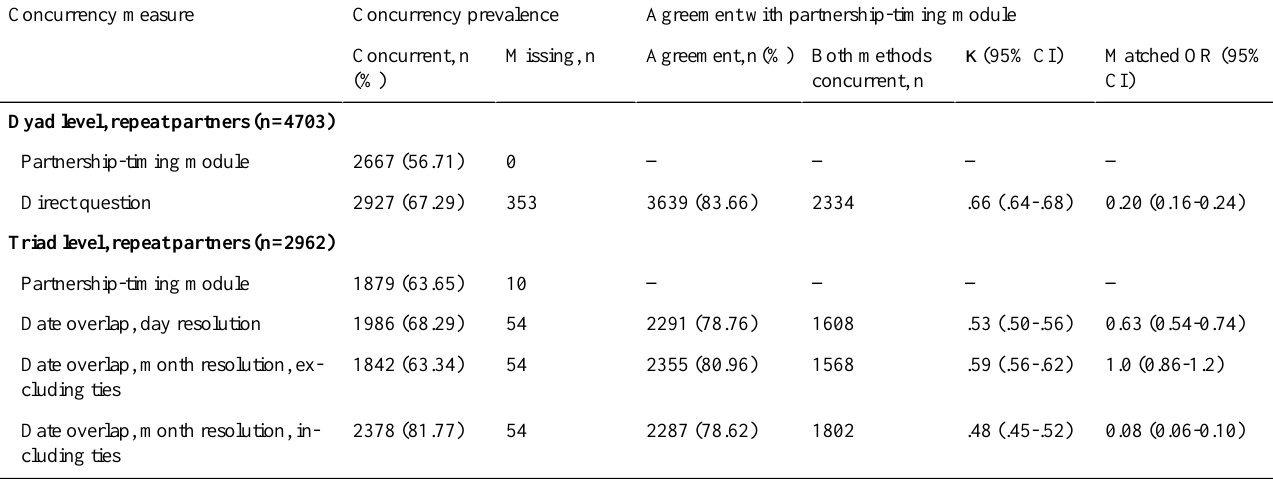
Table 1, but are excluded from the subsets of participants with multiple partners in Table 2. b Date overlaps measures exclude 1-time partners, for whom dates of sex were not asked. c UNAIDS point prevalence measures modified to 5 and 3 months from typical 6 months. Table 3. Dyad- and triad-level concurrency by partnership-timing module and alternative measures of concurrency among subsets of men who have sex with